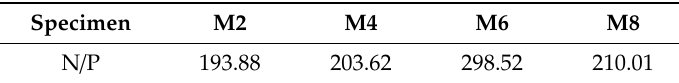
Table 2. N / P ratios in the immersion